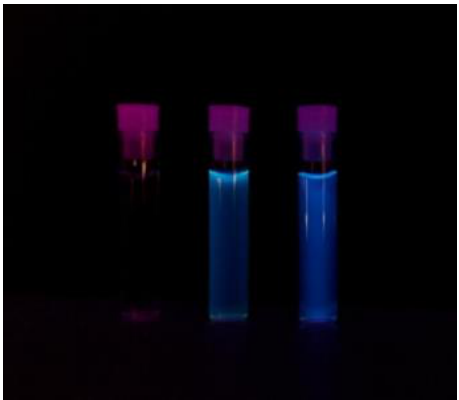
Figure 2. Optical images of three vials exposed to UV light: water (left), 10× diluted CQDs solution (middle) and non-diluted CQDs solution (right).